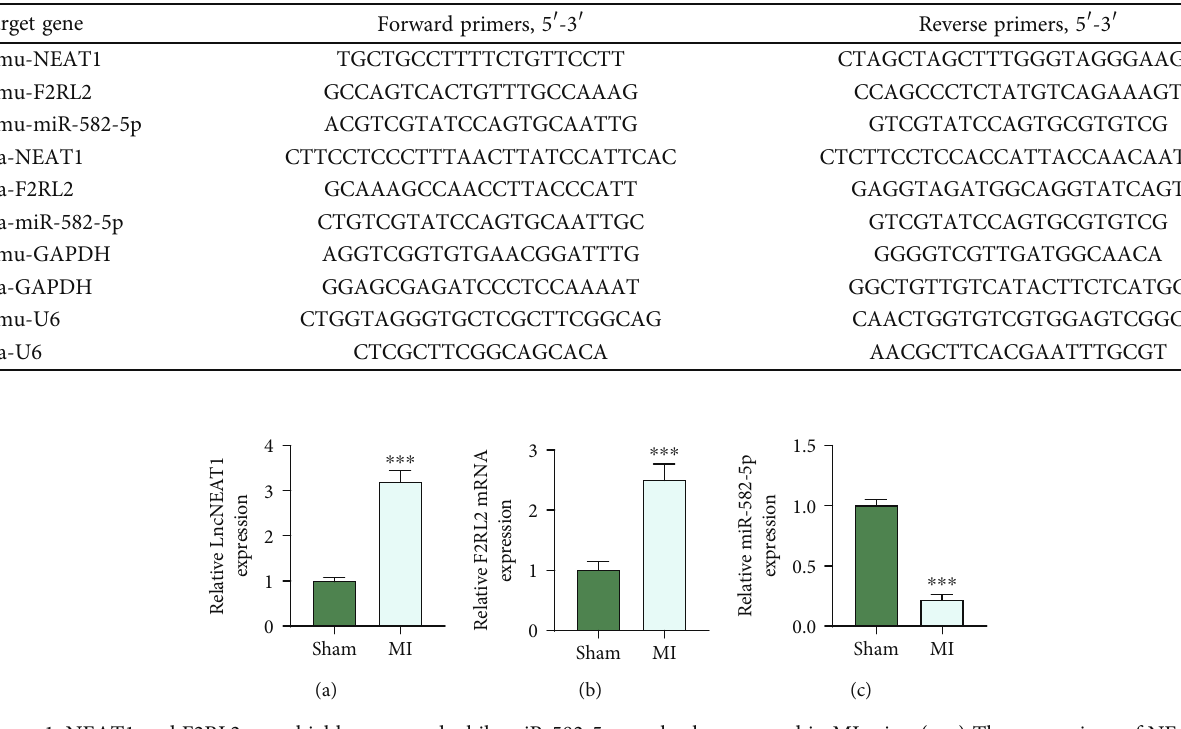
Table 1: All primers used in qRT-PCR in this study.